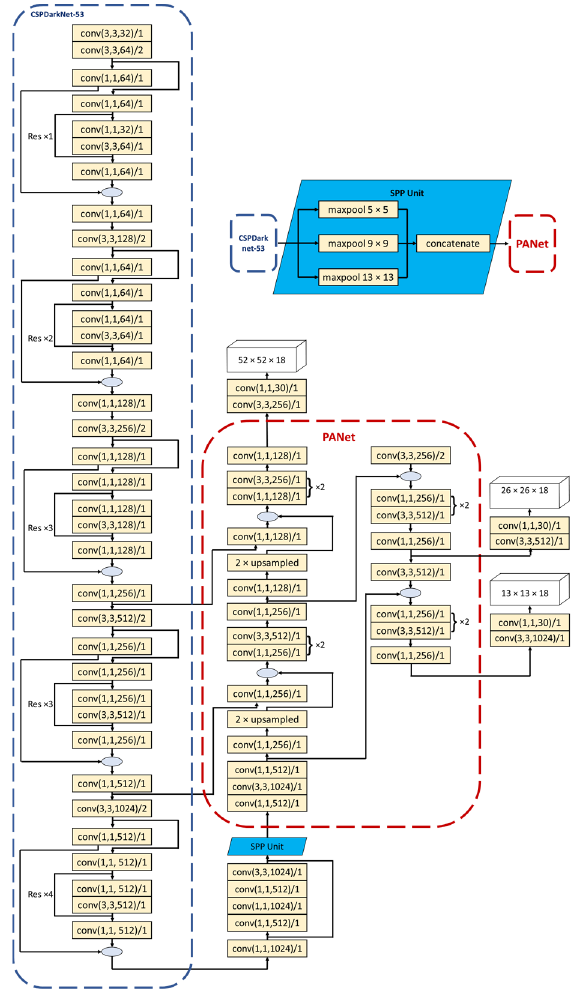
Figure 6. The network architecture of FC-YOLOv4.